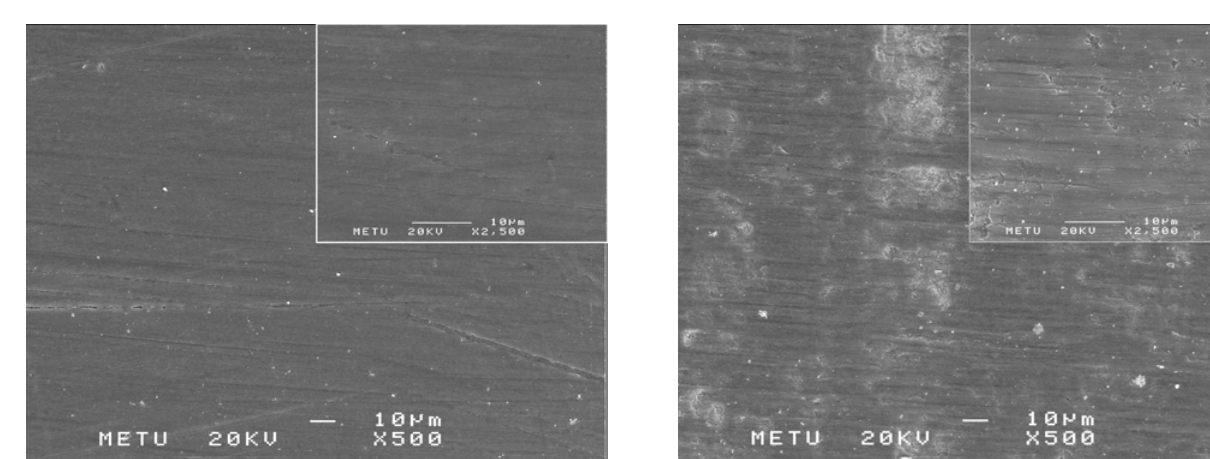
FIGURE 4- SEM analysis of the enamel surface after using Super-Snap Rainbow discs